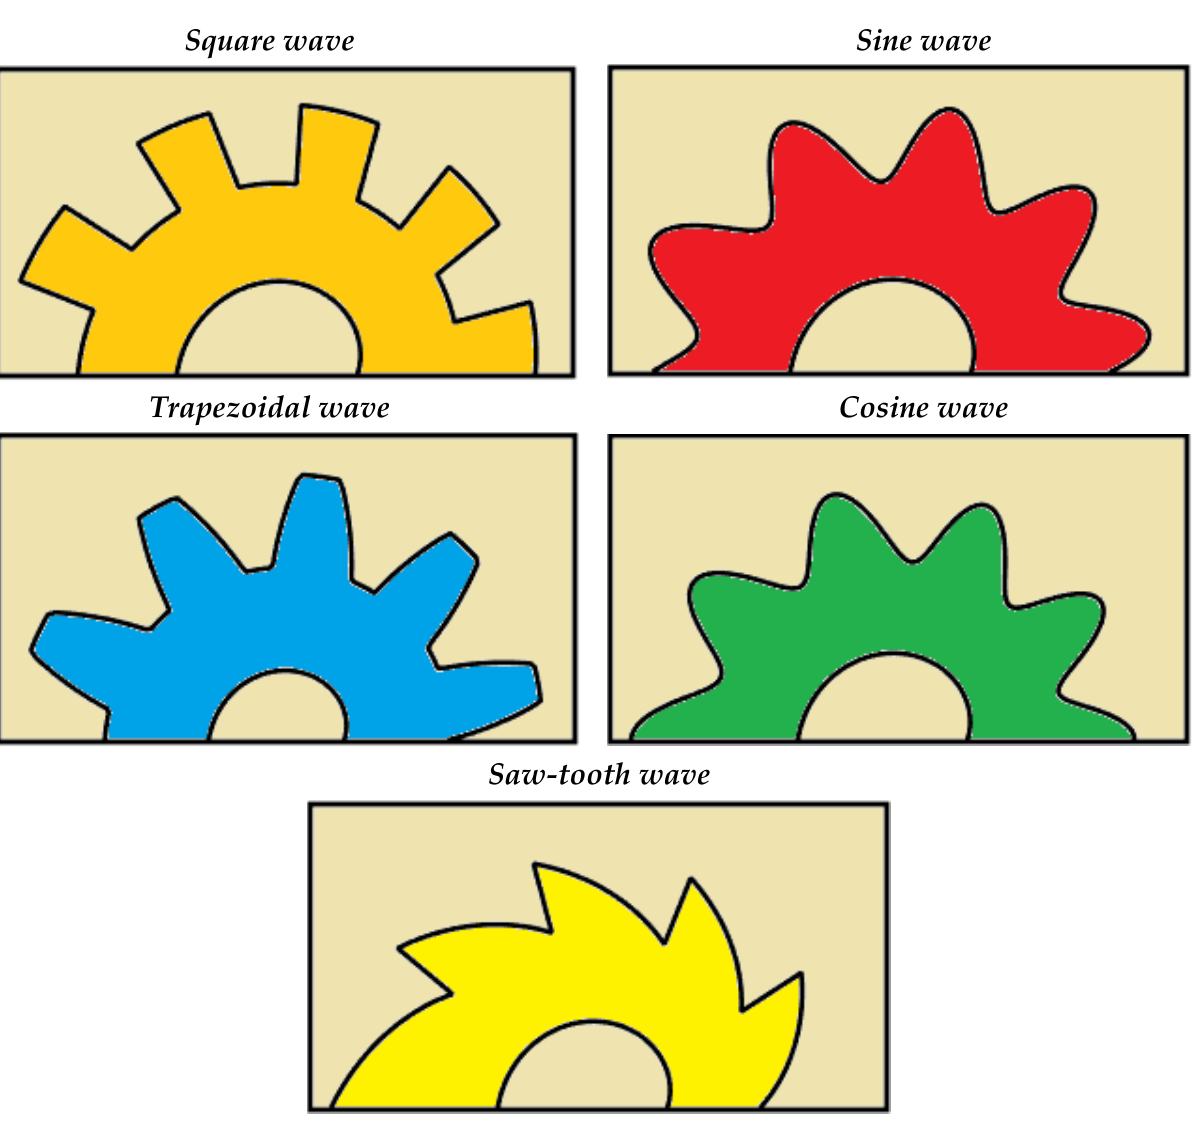
Figure 1. Peristaltic pumps.